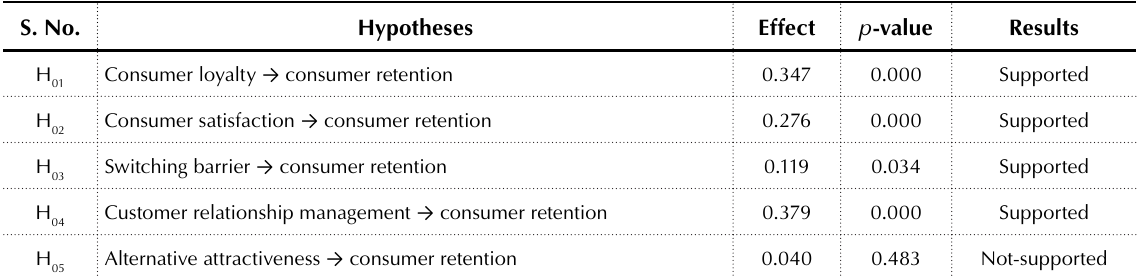
Table 4. Hypotheses testing